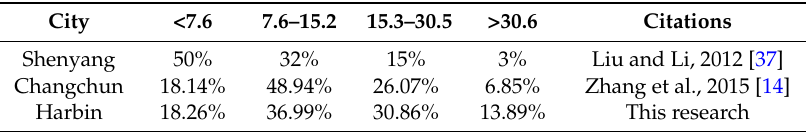
Table 3. Urban forest tree diameter distribution in major cities in northeastern